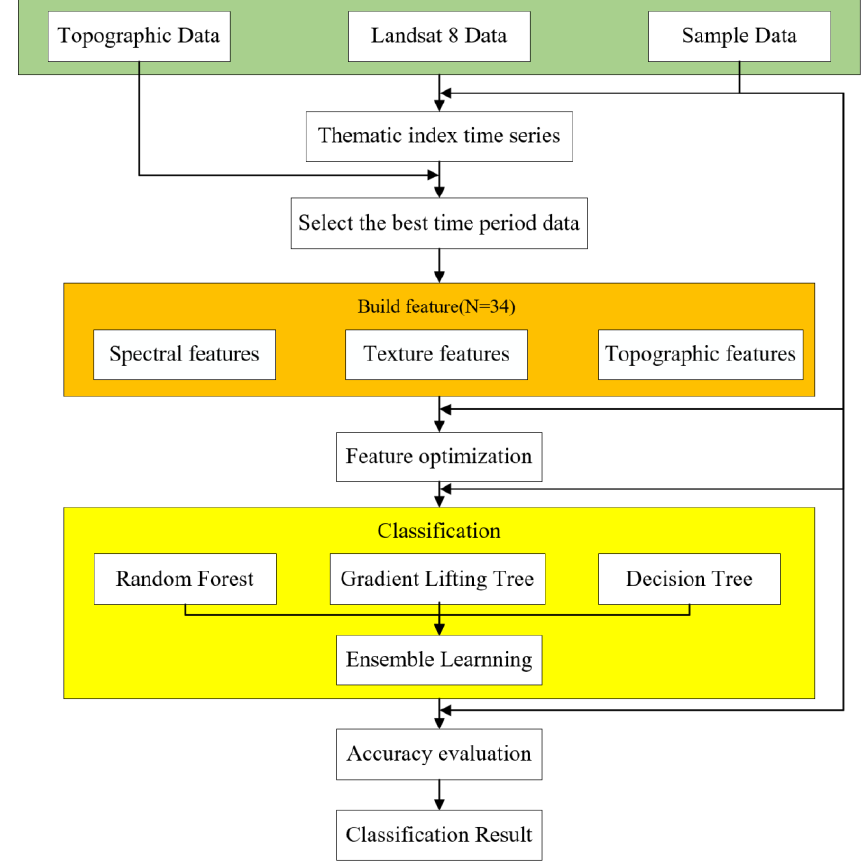
Figure 4. Technical flowchart.